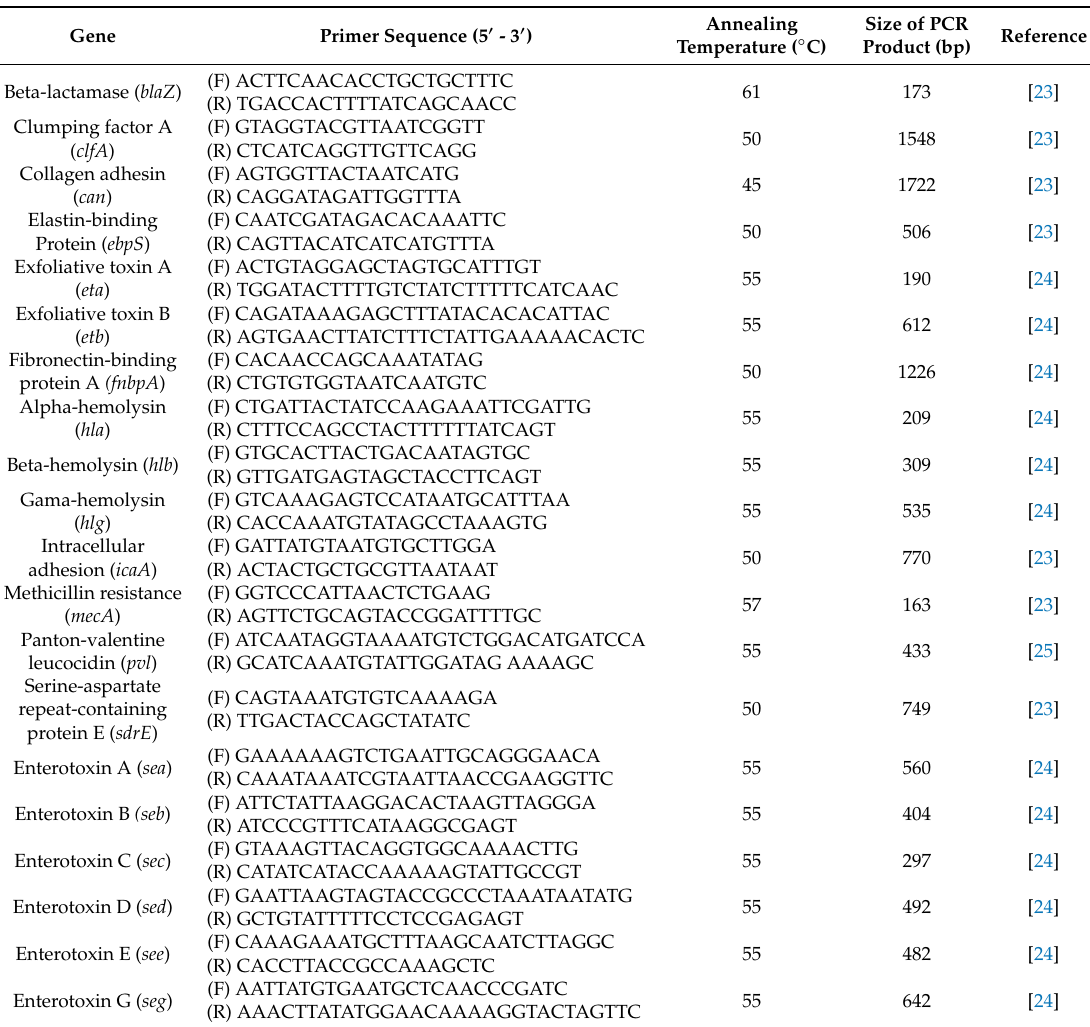
Table 1. Primer used for PCR, size of amplified products, and annealing temperatures. Gene Primer Sequence (5 (cid:48) - 3 (cid:48)